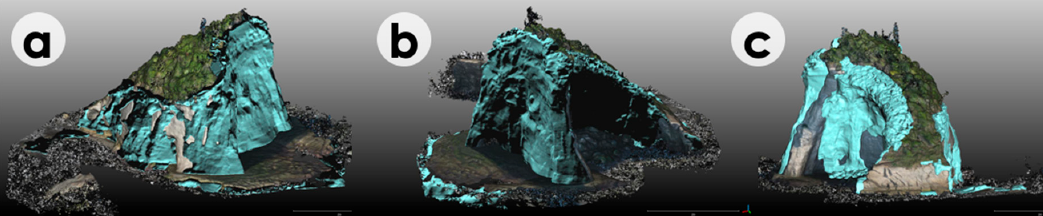
Figure 5. DVE for the entire period showing the total change of the island from June 24, 2014, to October 2, 2019. The total volume loss during this period was 1,979.5 m 3 . ( a ) The southeast side; ( b ) the northeast side; and ( c ) the west side.